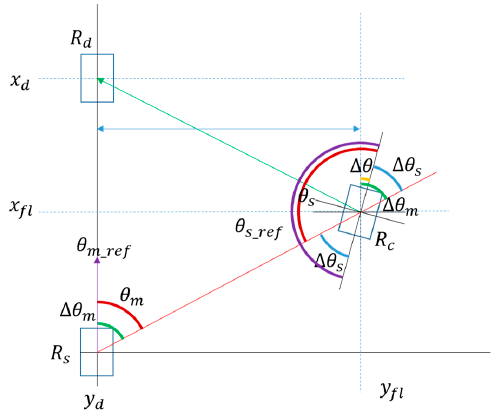
Figure 13. Geometry of a robot’s twisted-degree estimation for direction alignment.